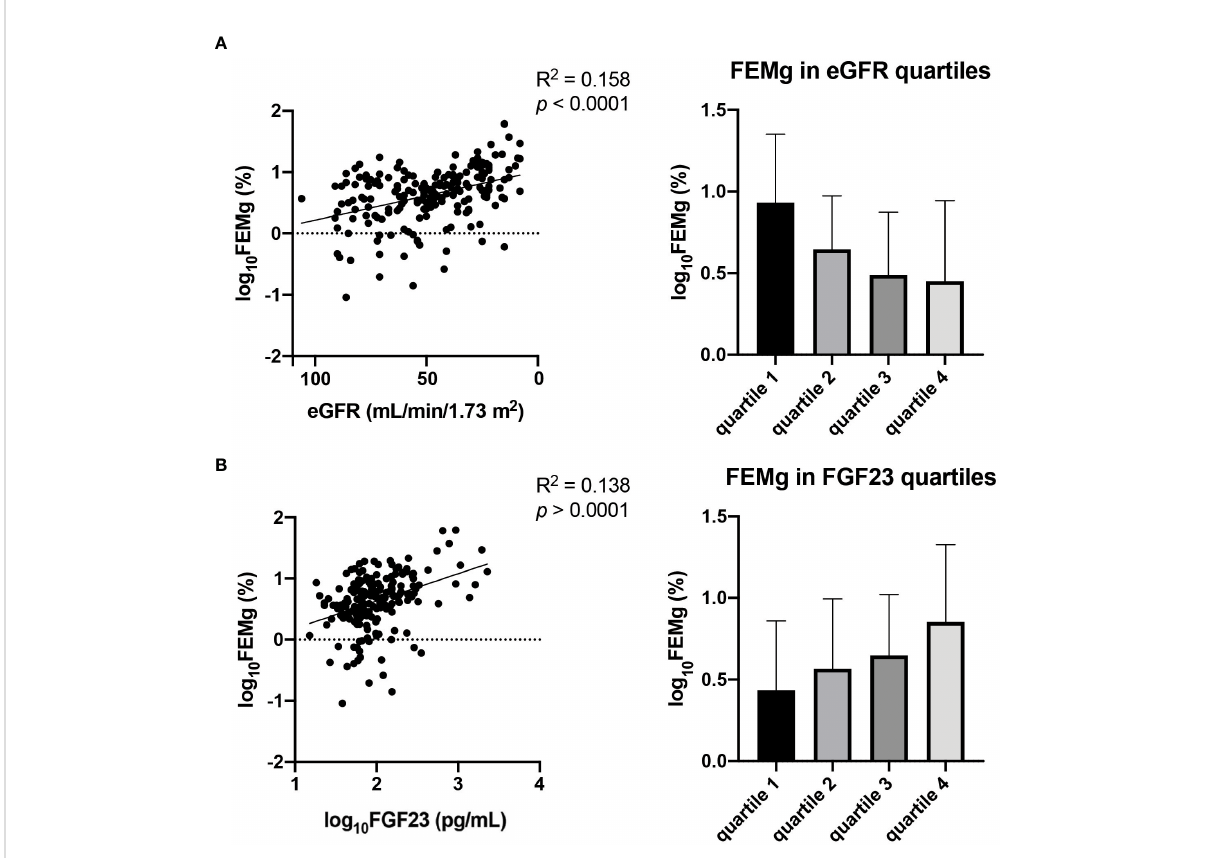
FIGURE 3 Association between eGFR and FEMg (A) in comparison with the association of FGF23 and FEMg (B) . Data are the outcomes of simple linear regression analysis.